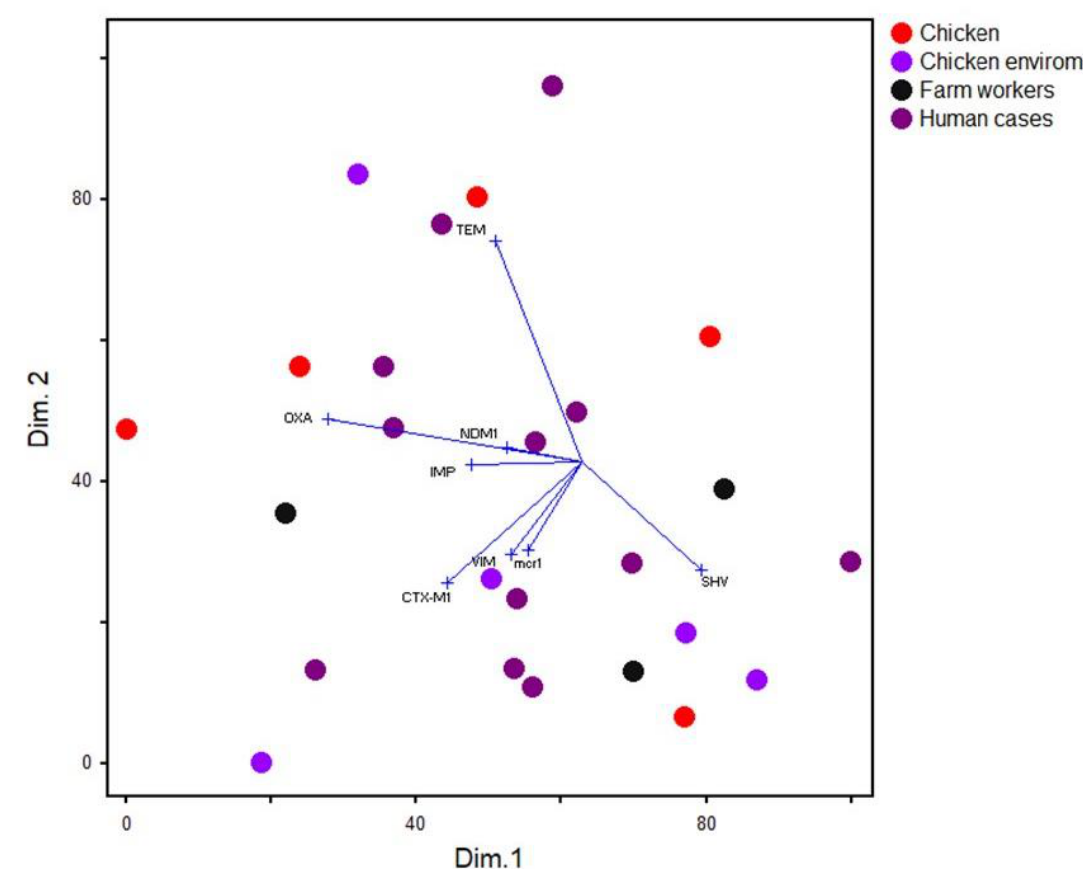
Figure 1. Non-metric multidimensional scaling biplot showing the overall distribution of isolates from various hosts based on the frequency distribution of antimicrobial resistance genes. Each dot refers to one isolate and the arrows refer to the association of each gene with either dimension 1 or 2.